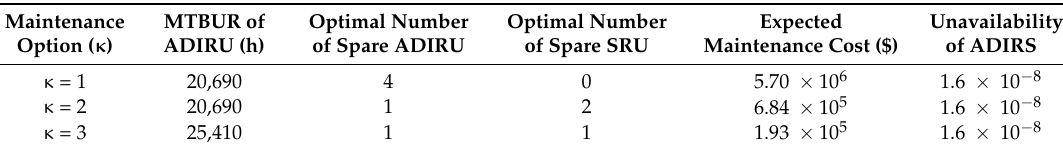
Table 1. Calculation results for three options of air data inertial reference system (ADIRS) maintenance. Maintenance Option ( κ